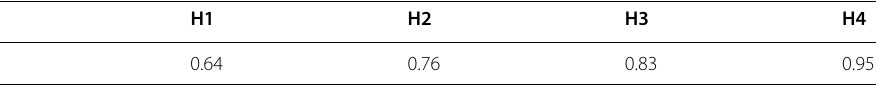
Table 4 Calculation of index